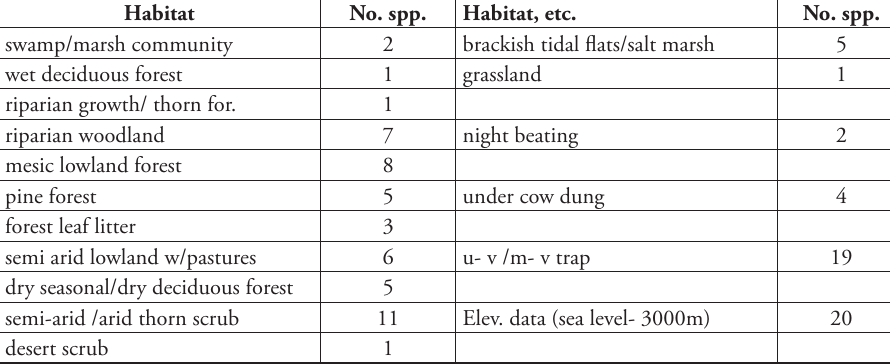
Table 2. Label data for West Indies collection of selenophorine species with number of species collected at each type of site.